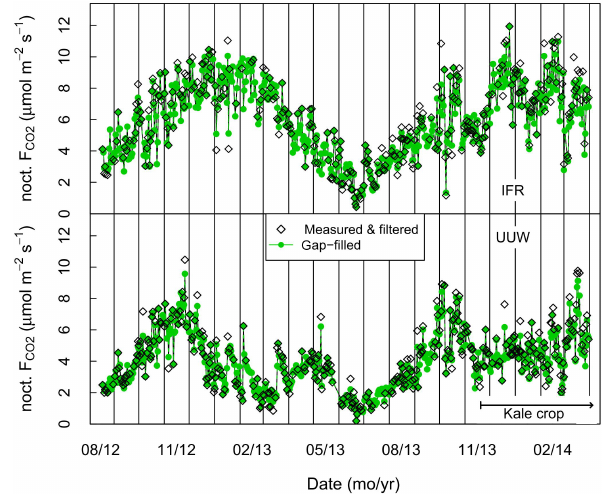
Figure 9. Nocturnal CO 2 emission rates from the IFR site (top) and the UUW site (bottom). Each point is a whole-night average, obtained either only from measured values during periods with suf- ficient turbulence ( σ w >0.12ms − 1 ; open diamonds), or from the complete gap-filled data set (solid